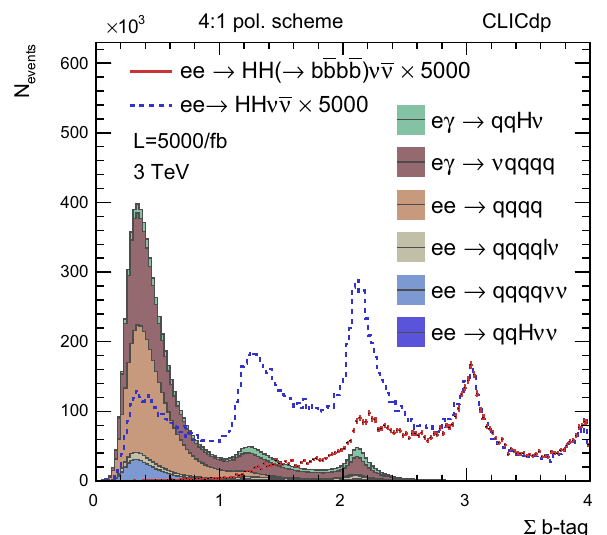
Fig. 4 Distribution of the sum of the b -tag values for the inclusive HH ν ¯ ν and the HH ν ¯ ν → b ¯ bb ¯ b ν ¯ ν channel, both scaled by a factor 5000 for better visibility, and for the background processes. No selection is applied ¯ ¯ ¯ b bb b and b bWW ∗ candidates in the following way: Events ¯ are chosen as b bWW ∗ candidates if the sum of the b -tag val- (cid:2) b -tag of the jets is smaller than 1.5 (2.3) at ues 4